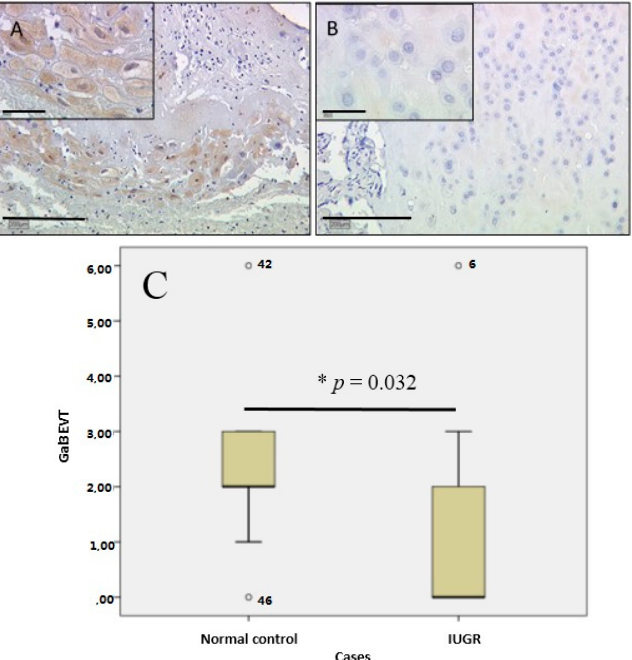
( A ); in cases of IUGR, extravillous trophoblast staining revealed a totally absent expression in 60% of